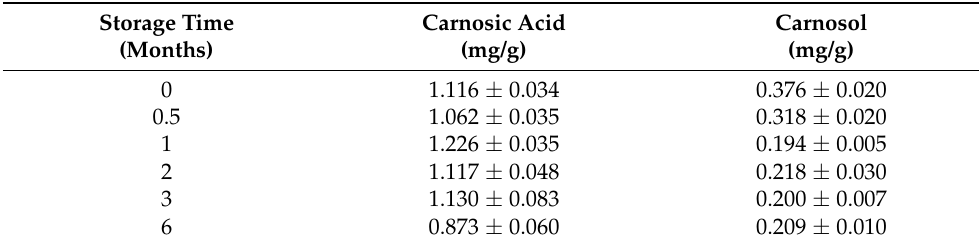
Table 7. The content of carnosic acid and carnosol in macerate depends on the storage time at refrigerated temperature (4 ◦ C).